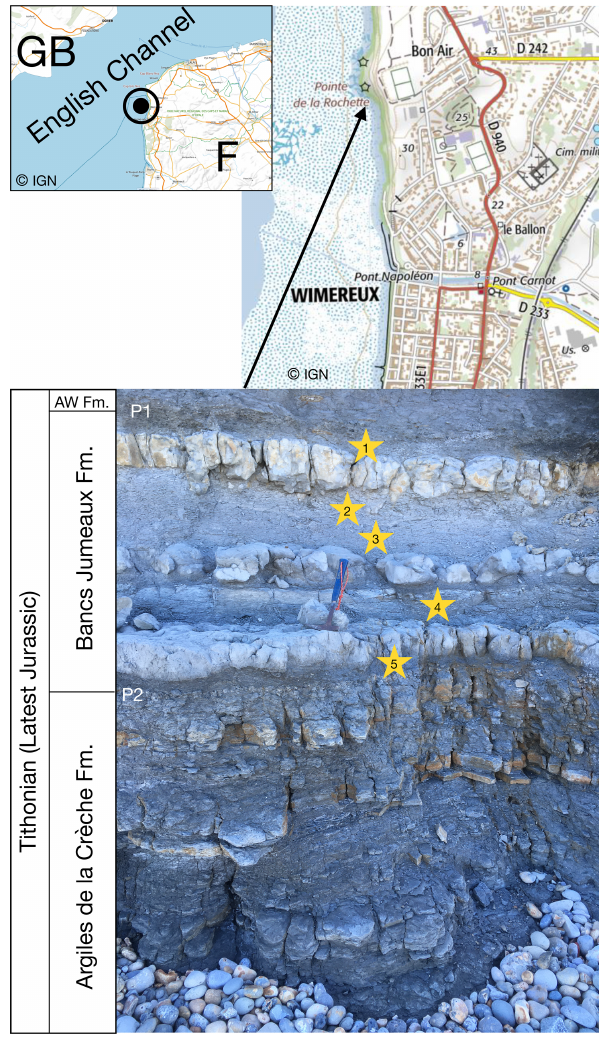
Figure 1. Location of the outcrop of the Bancs Jumeaux Fm. sam- pled here, north of Wimereux, at the place called “Pointe de la Ro- chette”. The maps were drawn using the Institut Géographique Na- tional Géoportail. The Bancs Jumeaux Fm. is intercalated between the underlying Argiles de la Crèche Fm. and the overlying Argiles de Wimereux Fm. (AW Fm.).